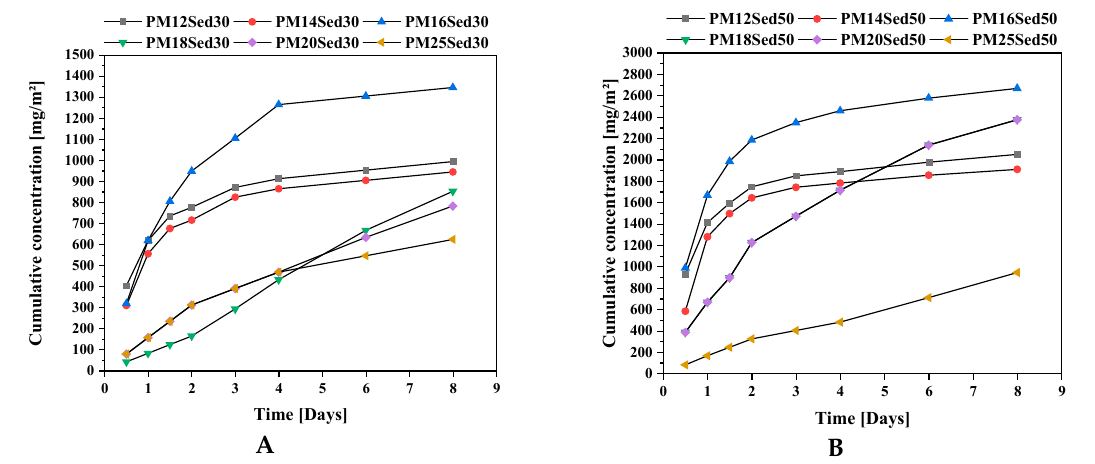
Figure 9. Evolution of cumulative concentration of Sulfates in leachates from monolithic polymer mortars containing 30% ( A ) and 50% ( B ) of sediments in their matrices.